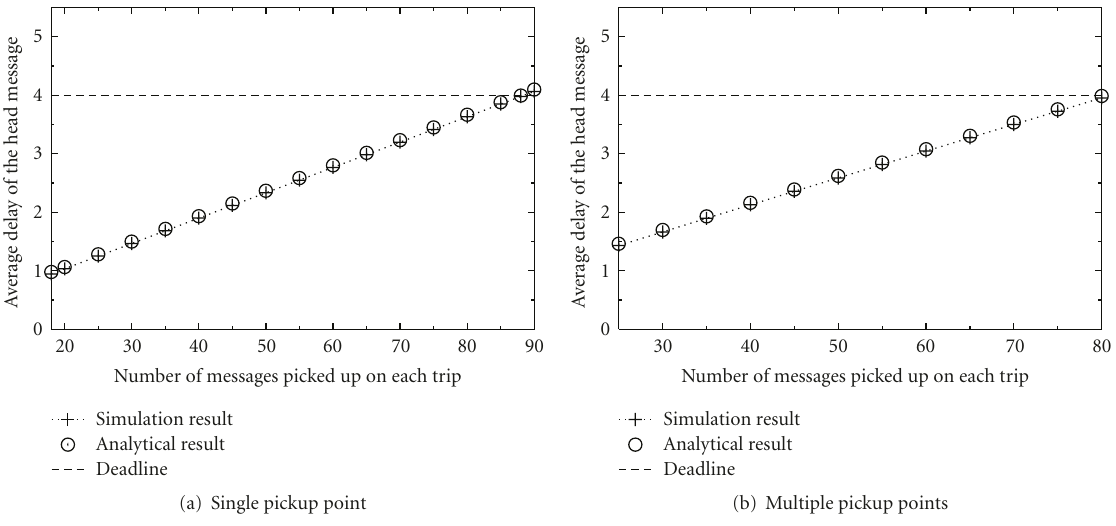
Figure 4: Comparison of delay with di ff erent packing